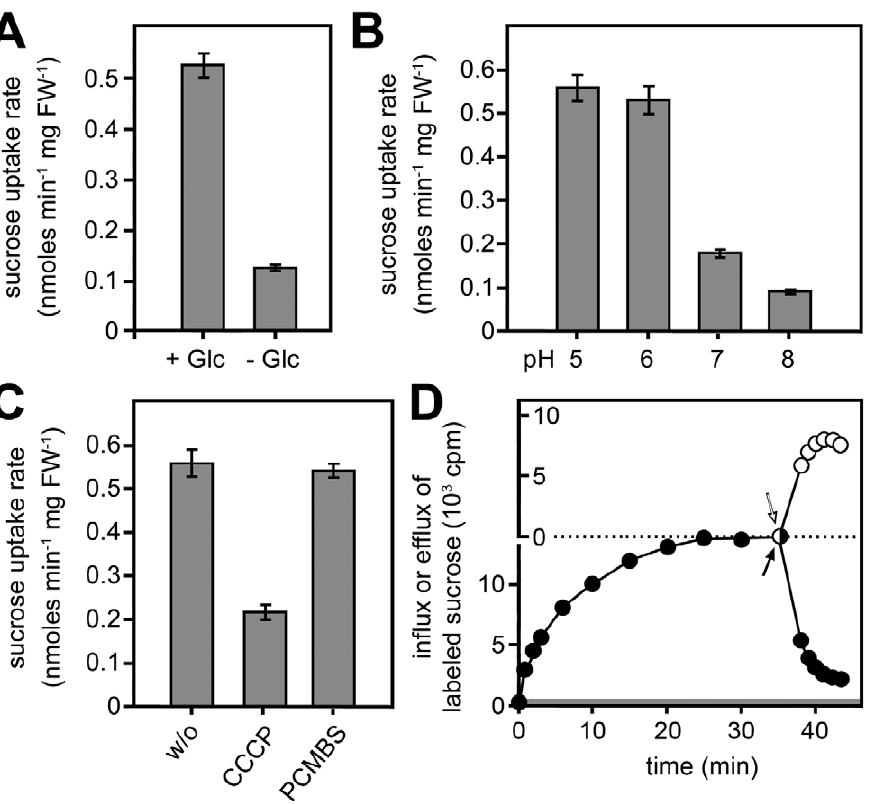
Figure 6. Transport characteristics of Srt1. (A) Transport is activated in the presence of the metabolizable carbon source glucose (Glc). (B) The pH optimum for sucrose uptake by Srt1 is in the acidic pH range. (C) Sucrose uptake is sensitive to the protonophore CCCP, but not to the SH-group inhibitor PCMBS. w/o, without. (D) The plateau of sucrose accumulation in baker’s yeast results from an equilibrium of influx and efflux. Black symbols show the uptake of 14 C-labeled sucrose and the onset of an immediate efflux, after replacement of labeled extracellular sucrose by unlabeled sucrose (black arrow). The grey region at the bottom of the graph shows the amount of sucrose that was sufficient to reach a concentration equilibrium of 14 C-sucrose between the medium and the cell interior. White symbols show the onset of an immediate influx of 14 C-labeled sucrose in an identical experiment that was started with unlabeled sucrose. The white arrow indicates the replacement of unlabeled extracellular sucrose by 14 C-labeled sucrose. One of three experiments with identical results is presented. Error bars in (A) to (C) represent standard error ( n =3). doi:10.1371/journal.pbio.1000303.g006 by AtSUC9. Nevertheless, it could well be that SG200 D srt1 :: At- SUC9 would show reduced virulence in the field, where growth conditions are more competitive.